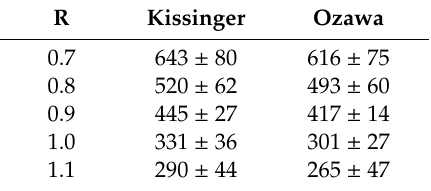
Table 5. The fitting equations and R 2 . R